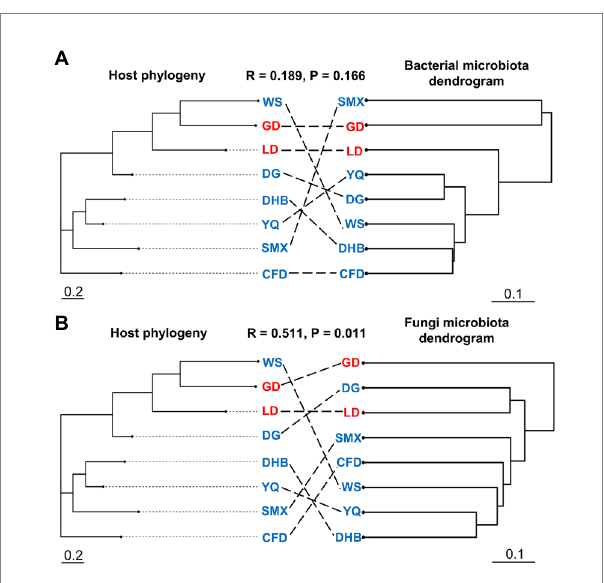
FIGURE 3 The neighbor-joining tree of wild soybean populations (left panel) and dendrogram of hierarchical clustering of Bray–Curtis dissimilarity of the bacterial (A) and fungal (B) communities (right panel). The eight genotypes of the microbial community were averaged using biological